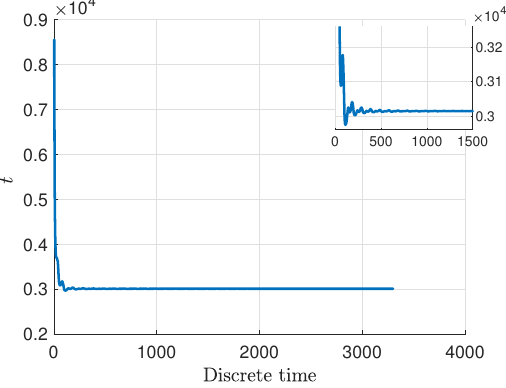
Figure 10. Parameter variables p 1 ( a ) and p 2 ( b ).